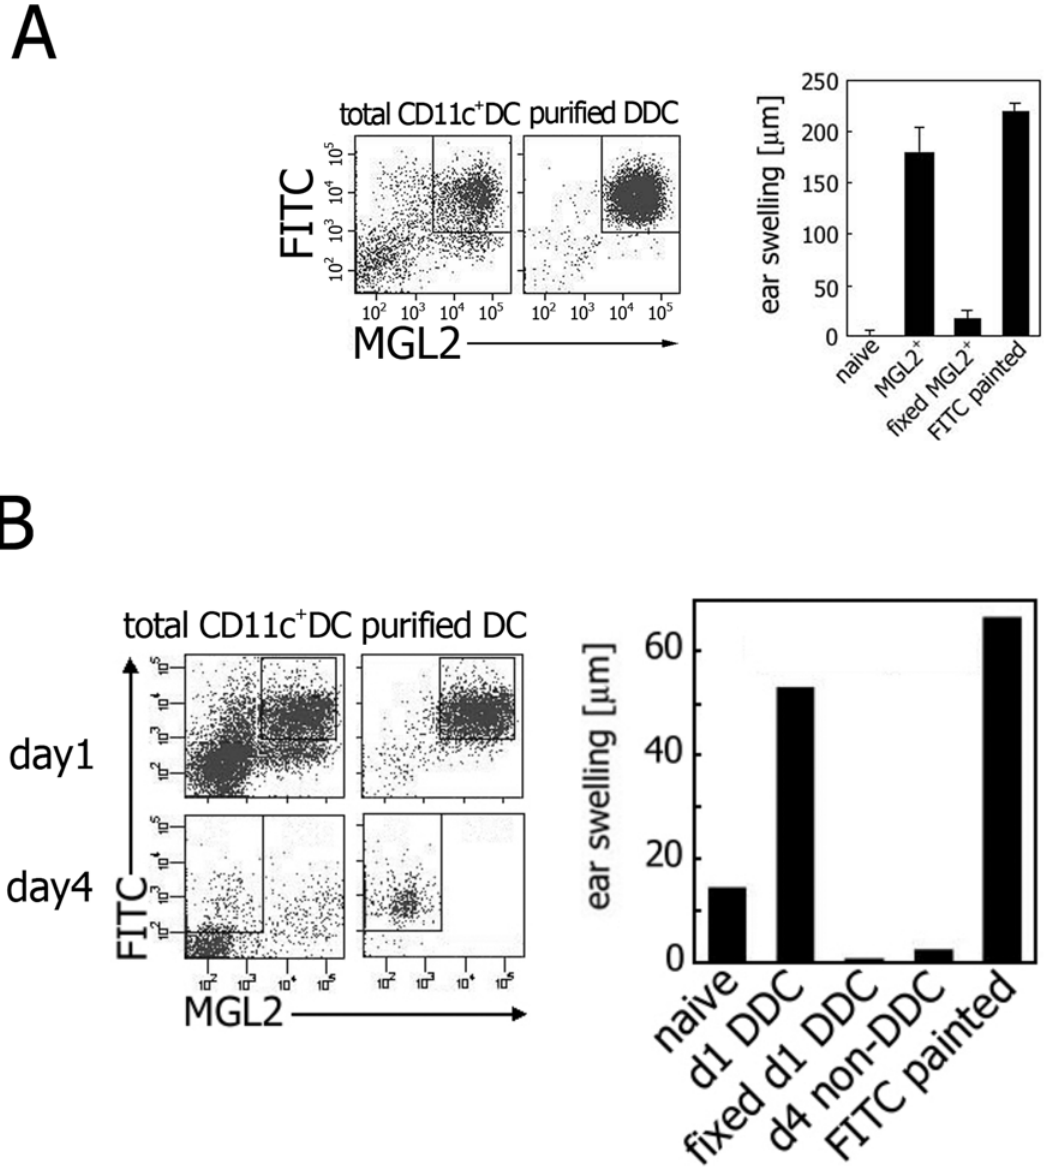
Figure 7. Induction of FITC-specific CHS in mice adoptively transferred with FITC + MGL2 + DDC. (A) The left panels show the gating to sort FITC + MGL2 + cells from the MACS-purified CD11c + cells. The purity of FITC + MGL2 + DDCs was approximately 98%. Ear swellings in mice transferred with FITC + MGL2 + DDCs (‘‘MGL2 + ’’, p , 0.005), transferred with glutaraldehyde-fixed FITC + MGL2 + DDC (‘‘fixed MGL2 + ’’, difference not statistically significant), sensitized directly with FITC painting (‘‘FITC painted’’, p , 0.005), or untreated (‘‘naive’’) are shown in the graph. Each bar indicates mean 6 SD obtained from three independent recipients respectively. (B) The left panels show the gating strategy to sort FITC + MGL2 + DDCs from the day 1 LNs or FITC + MGL2 2 DCs from the day 4 LNs. The purity of sorted cells was . 90% when re-analyzed by FACS. Ear swelling in mice transferred with 5 6 10 4 cells of FITC + MGL2 + DDCs from the day 1 LNs (d1 DDC), glutaraldehyde-fixed FITC + MGL2 + DDCs from the day 1 LNs (fixed d1 DDC) or FITC + MGL2 2 DCs from the day 4 LNs (d4 non-DDC) is shown in the right panel. The mice sensitized by FITC painting (FITC painted) and left untreated (naive) were used as positive and negative controls respectively. Each bar indicates the mean value from two recipients and the data are representative of two independent